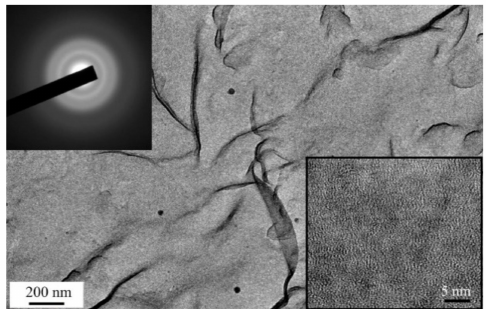
Figure 8. TEM image and SAED pattern of thin MoS x ~3 + δ thin film obtained by o ff -axis PLD in Ar at a pressure of 8 Pa. The bottom insert shows the high resolution TEM image of the film.